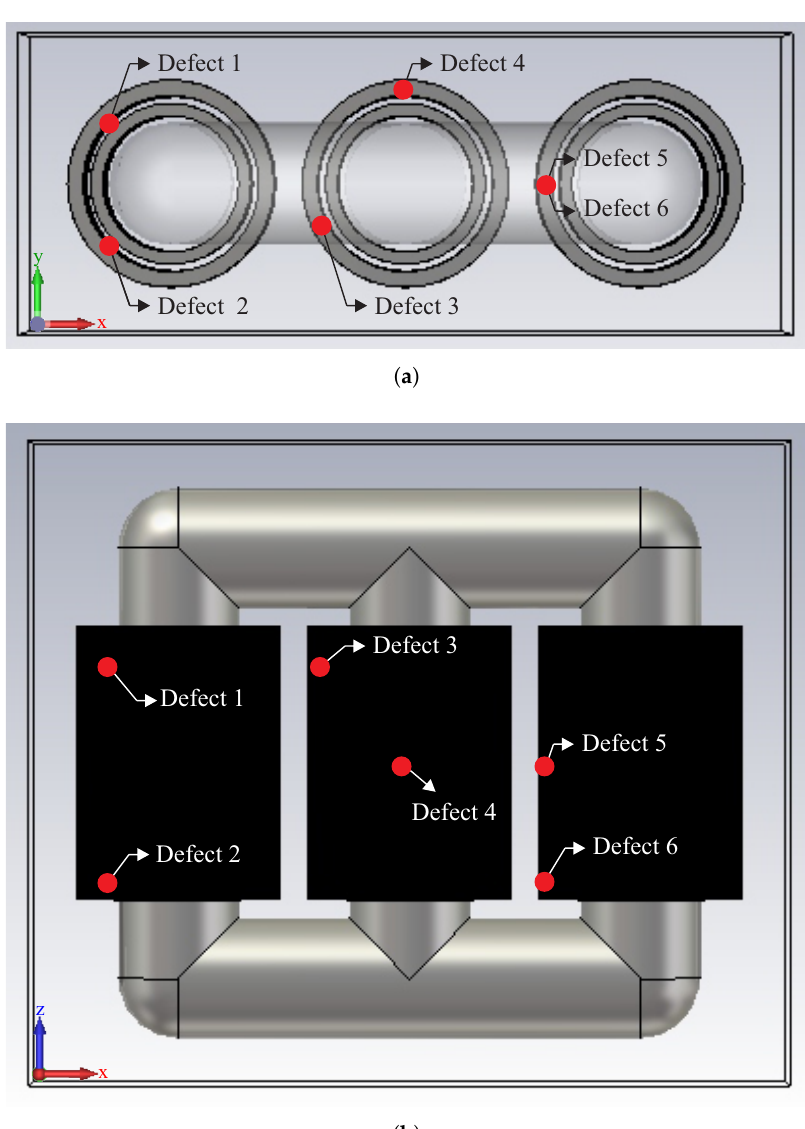
Figure 5. Position of simulated defects: ( a ) Top view of the simulated transformer, and ( b ) front view of the simulated